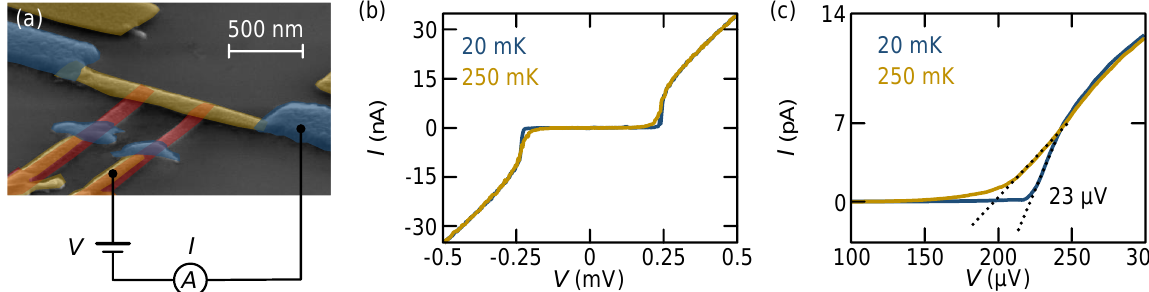
Figure 4. Measurement of the density of states in a 1DJ. ( a ) False-color scanning electron micrograph of a device used to measure the DOS of a 1DJ. The 1DJ is made of an Al/Cu bilayer nanowire (yellow) interrupting two Al electrodes (blue). The Al probes (red) allow to perform tunnel spectroscopy. In the experiment, a voltage ( V ) is applied between A and one probe while recording the current ( I ). ( b ) Tunneling current ( I ) as a function of voltage ( V ) characteristics recorded at T bath = 20 mK (blue) and T bath = 250 mK (yellow). ( c ) Zoom of the IV characteristics in correspondence of the transition to the normal-state. It is possible to extract ∆ A ,0 (cid:39) 23 µ eV and ∆ P ,0 (cid:39) 200 µ eV as the crossing between the black dotted lines and I =